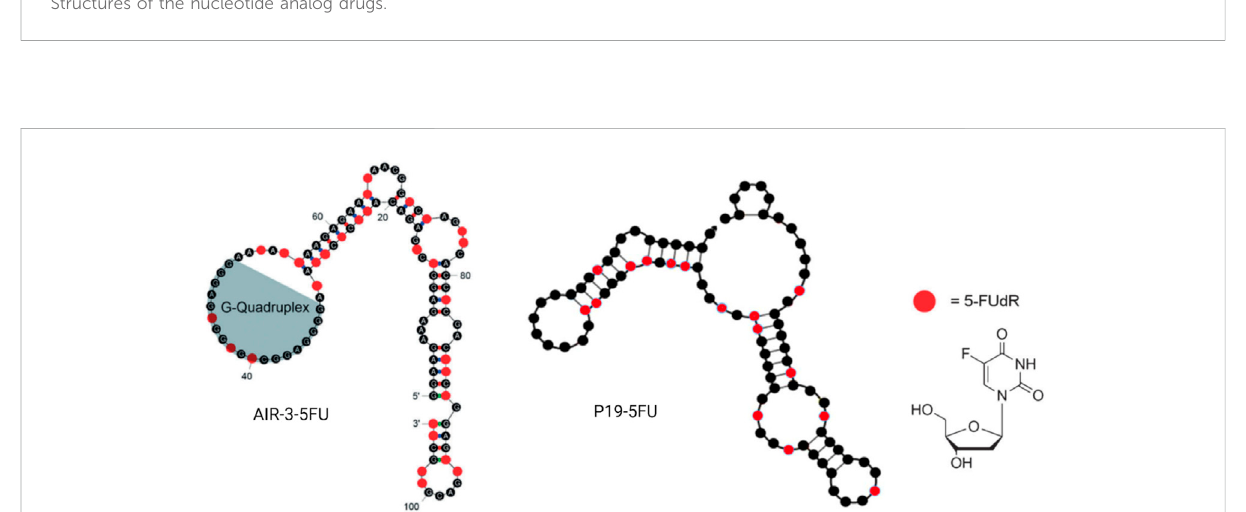
FIGURE 6 Structures of the nucleotide analog